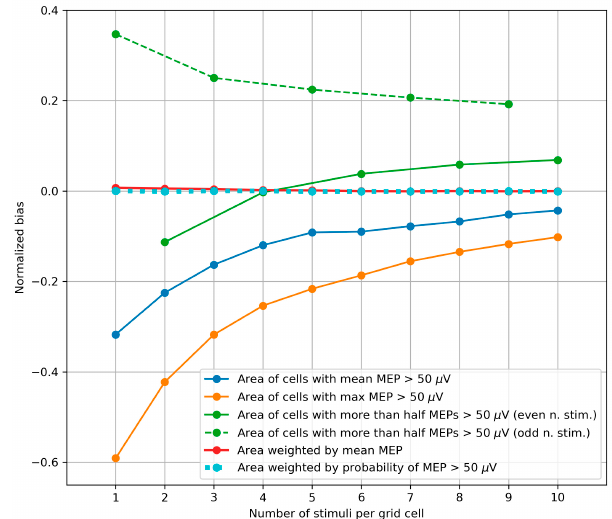
Figure 3. The dependence of the normalized bias of the representation parameters on the number of TMS stimuli per grid cell. The values of the parameters were averaged by 1000 maps generated by bootstrapping (with replacement) from every experimental map obtained with 10 stimuli per cell in each subject. The median values from all maps of all subjects are depicted. The area of the cells with more than half suprathreshold MEPs showed different patterns for even and odd numbers of stimuli per cell (see also Figure A3 in Appendix B). These subseries are shown separately by the solid and dashed green lines respectively (here and in Figures 4 and 5). The biases of the mean amplitude-weighted and probability-weighted areas are close to zero, and thus the red and cyan curves are close to the X axis.